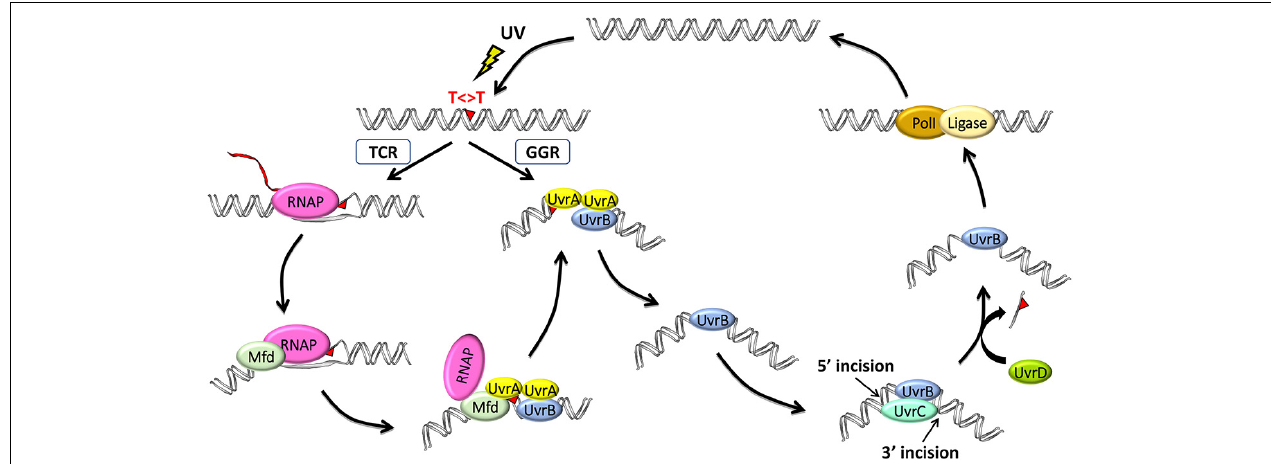
FIGURE 1 | Model for the two nucleotide excision repair pathways in E. coli : general global repair (GGR) and transcription-coupled repair (TCR). UV light induces thymine dimers in DNA which are either directly recognized by UvrA 2 B in the GGR pathway or indirectly recognized by RNA polymerase (RNAP) in the TCR pathway. Elongating RNAP stalls when it encounters a dimer in the template strand and recruits the mutation frequency decline (Mfd) translocase, which, in turn, removes RNAP while recruiting UvrA 2 B. The two pathways then converge after these initial damage-recognition steps, and UvrA 2 dissociates, leaving a stable preincision complex consisting of UvrB bound to damaged DNA, which now has an altered structure. UvrC is recruited to generate the coupled dual incisions, and UvrD removes UvrC and the damaged oligonucleotide. Repair is completed by synthesis and ligation of the repair patch by DNA polymerase I (PolI) and DNA ligase,